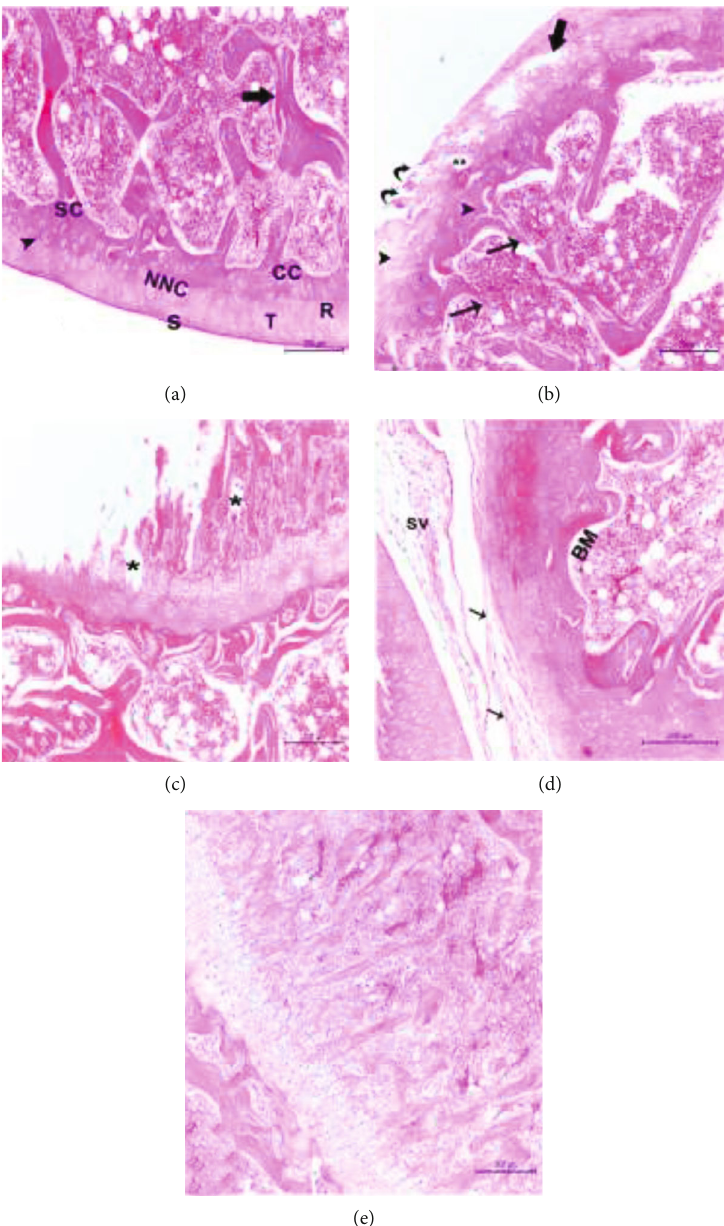
Figure 9: Photomicrographs of hematoxylin and eosin- (H&E-) stained sections of left knees joints of the following groups: (a) is a section from the control group which demonstrates the normal structure of articular cartilage, with a regular smooth intact surface and well- organized chondrocytes, which appeared in noncalci fi ed (NCC) and calci fi ed (CC) regions of cartilage with a clear intact tidemark (arrowhead) in between. The noncalci fi ed region (NCC) of the articular cartilage is arranged in three zones: super fi cial (S), transitional (T), and radial (R) zones. It also shows intact subchondral bone (SC) with well-oriented bony trabeculae (arrow) (scale bar = 200 μ m ). (b, c) Are sections from osteoarthritic rats (MIA-treated group). (b) Depicts clefting (curved arrows), surface erosion, degeneration of the surface layer with discontinuity of the matrix (star), discontinuous thin cancellous bone trabeculae having blind ends (arrows), decrease in thickness of articular cartilage, degenerated chondrocytes with pyknotic nuclei (arrowheads), and widening of bone marrow space (BM) containing less hemopoietic cells, invisible tidemark, and large, thickened area at the joint margin and disorganization of the articular cartilage with some cell clusters (thick arrow). (c) Shows the matrix change, loss, degeneration ( ∗ ), and heterogeneous distribution of chondrocytes in the growth plate. (d, e) Are sections from the treatment group (MIA+BMMSCs). (d) Displays intact synovial membrane (SV) and marked restoration of the normal structure of the articular cartilage intact surface and increase in its thickness and nearly normal bone marrow space (BM) compared to the MIA-treated group, organized fi brous connective tissue (thin arrows), clari fi cation of tidemark (arrowhead), and cell layers with few shrunken chondrocytes, some empty lacunae (scale bar = 200 μ m ). (e) Demonstrates neatly and normally oriented chondrocytes of the growth plate (scale bar = 200 μ m